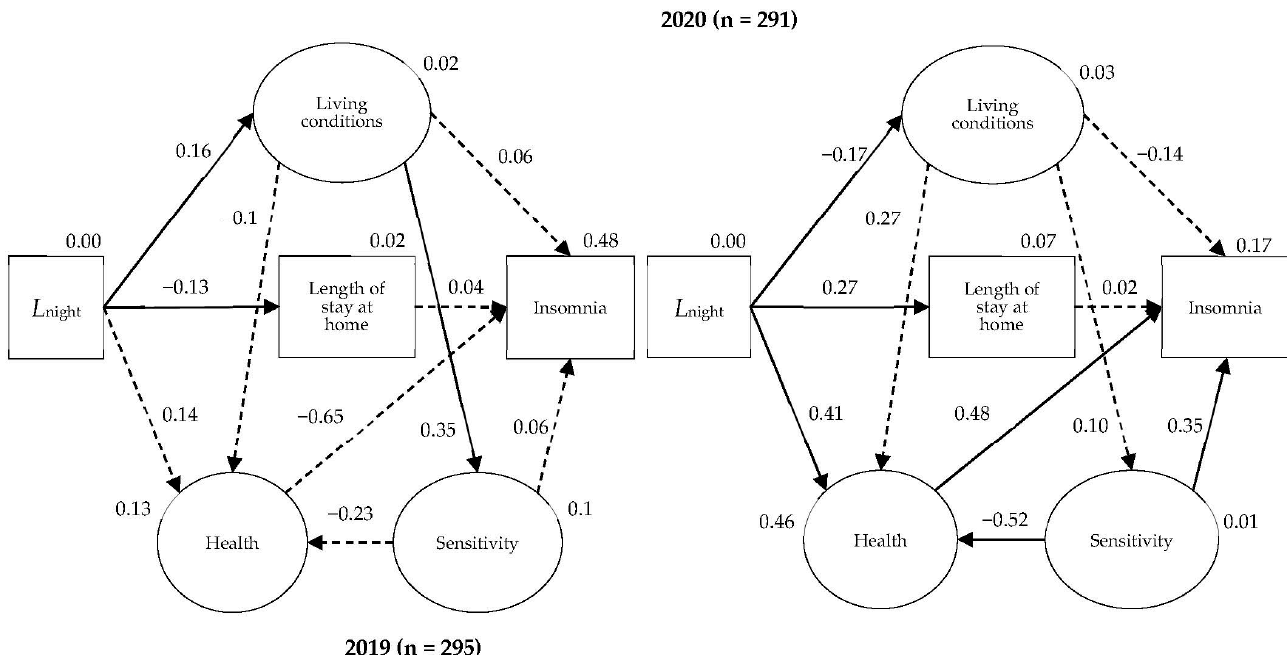
Figure 6. Structural equation model estimated for insomnia with length of time at home variable in the 2019 and 2020 surveys using chi-square, GFI, CFI, and RMSEA statistics: chi-square = 279.004, p < 0.01, df = 94, GFI = 0.928, CFI = 0.892, and RMSEA = 0.058. Statistically significant paths and standardized regression weights were annotated with ( p < 0.05). The non-significant paths are represented by dashed lines. The explained variances are annotated for each variable.